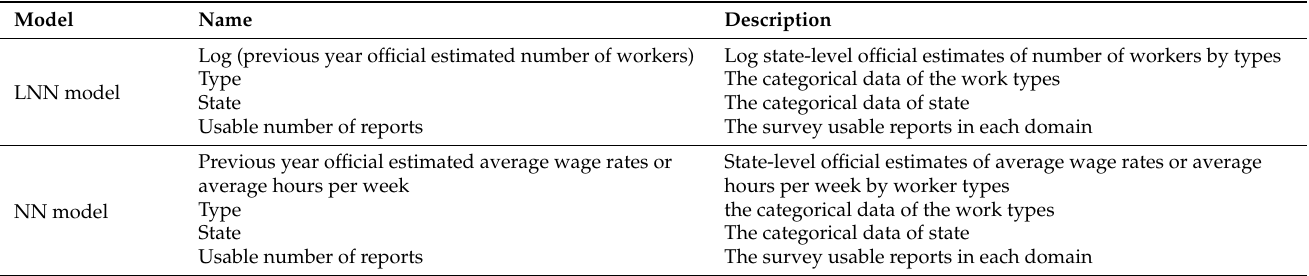
Table A1. The covariate definitions for the farm labor